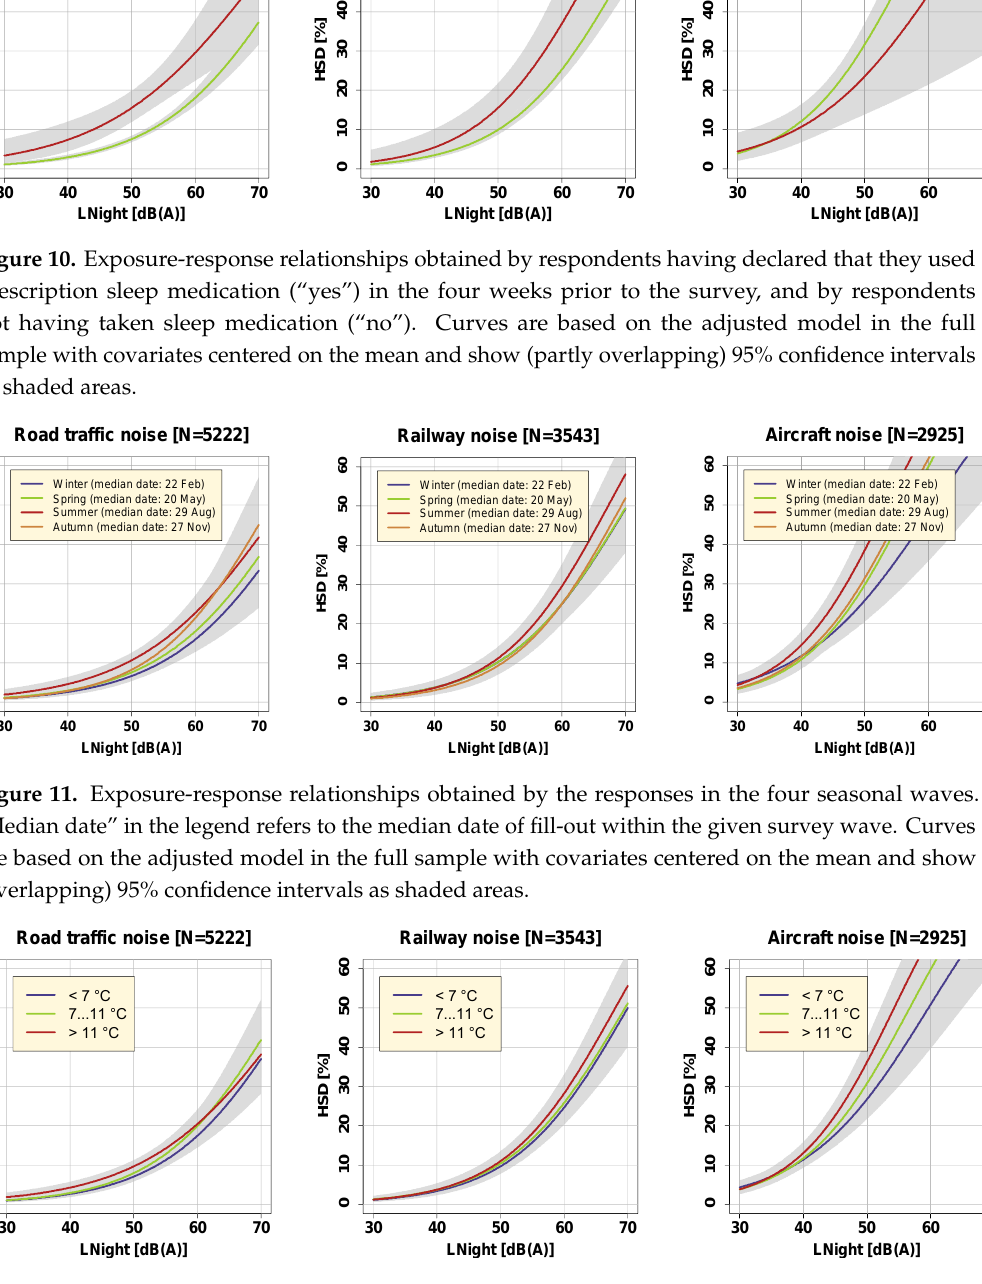
Figure 12. Exposure-response curves for three different night temperature categories including (overlapping) 95% confidence intervals (shaded areas). Curves are based on the adjusted model in the full sample with covariates centered on the mean. Figure 11. Exposure-response relationships obtained by the responses in the four seasonal waves. “Median date” in the legend refers to the median date of fill-out within the given survey wave. Curves are based on the adjusted model in the full sample with covariates centered on the mean and show (overlapping) 95% confidence intervals as shaded areas.